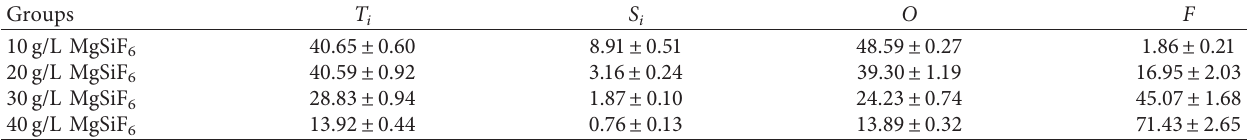
Figure 1: SEM microphotographs of MAO coating: (a) control group, (b) 10g/L MgSiF group, and (e) 40 g/L MgSiF 6 group. Bar � 1 μ m. Table 2: Effect of electrolyte concentrations on the Mao coating (wt%, n � 6). Groups